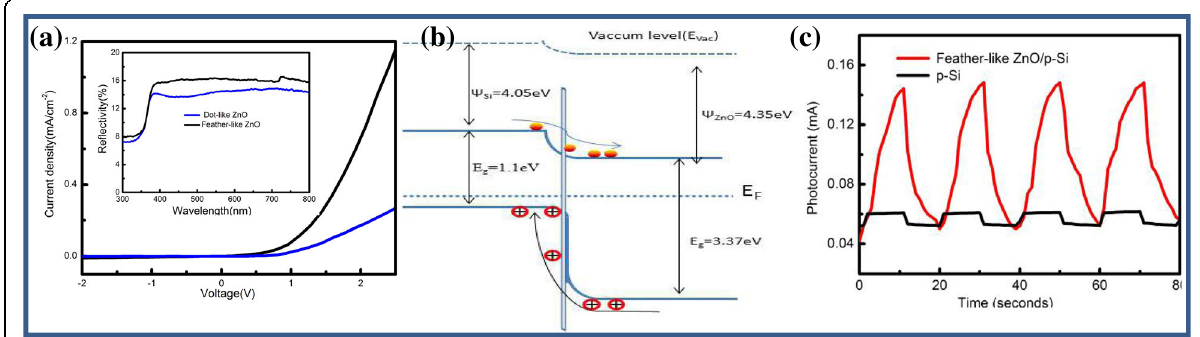
Fig. 6 a I - V curves of feather-like ZnO/Si and nano-dot ZnO/p-Si; the insert is the reflection spectra. b The energy band diagram of ZnO/p-Si heterojunction. c I - t curves of feather-like ZnO/p-Si and p-Si planar